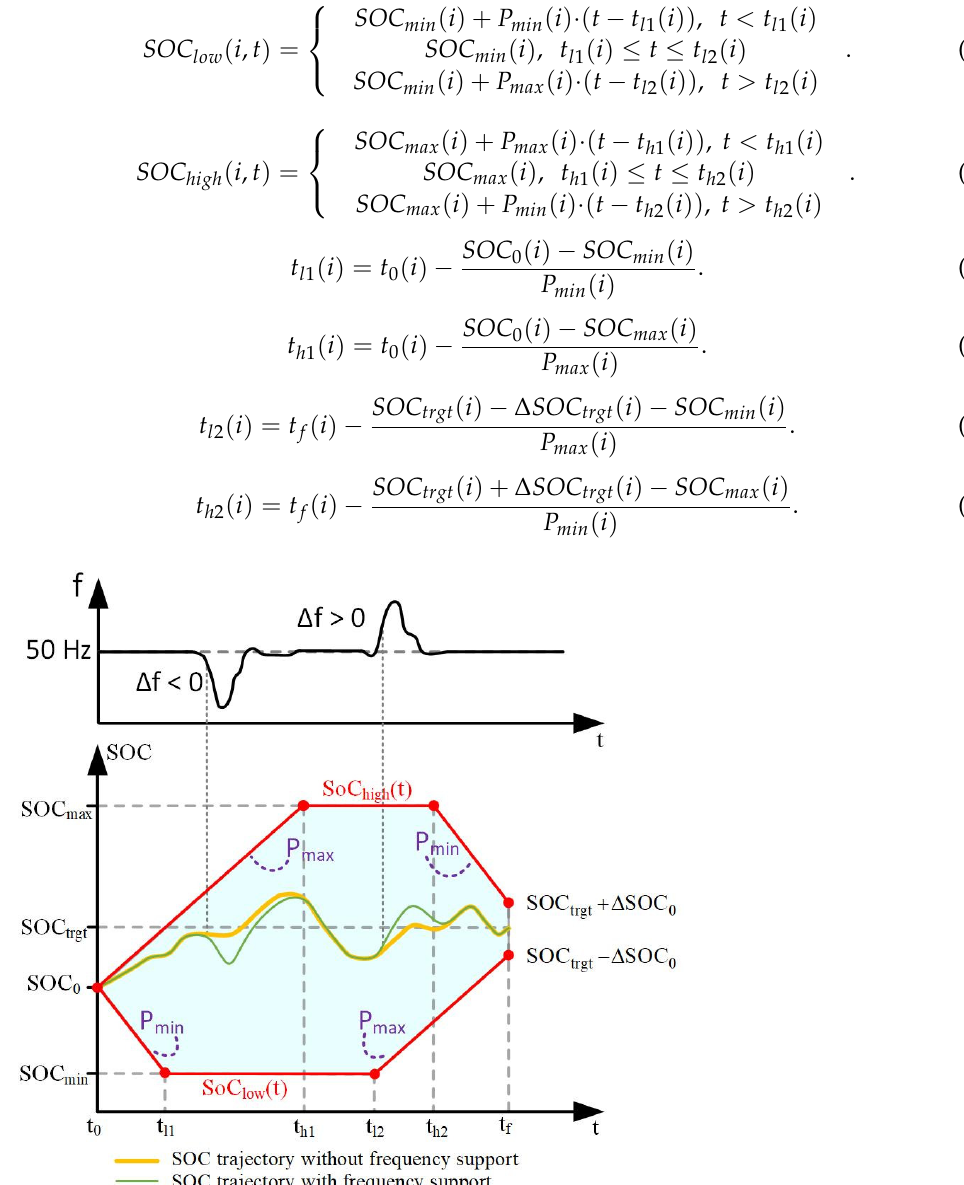
Figure 1. State-of-charge trajectory of an electric vehicle connected to a charger at time t 0 and disconnected at time t f .